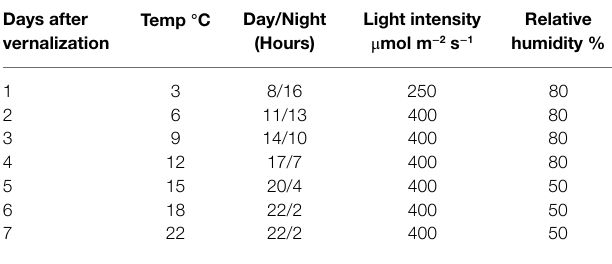
TABLE 1 | Growth conditions for acclimatization of vernalized winter wheat plants to the growth conditions of accelerated